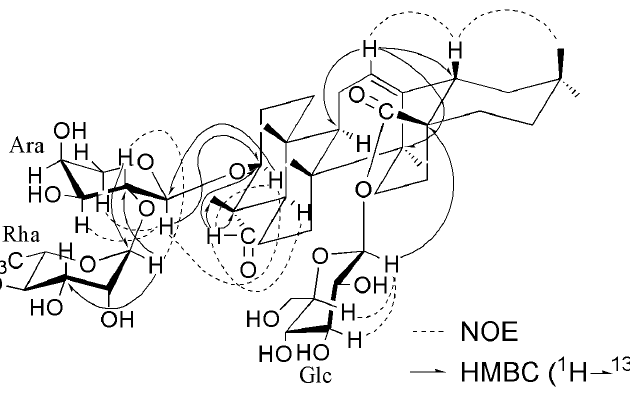
Figure 2. Key NOESY and HMBC correlations for compound 1 .